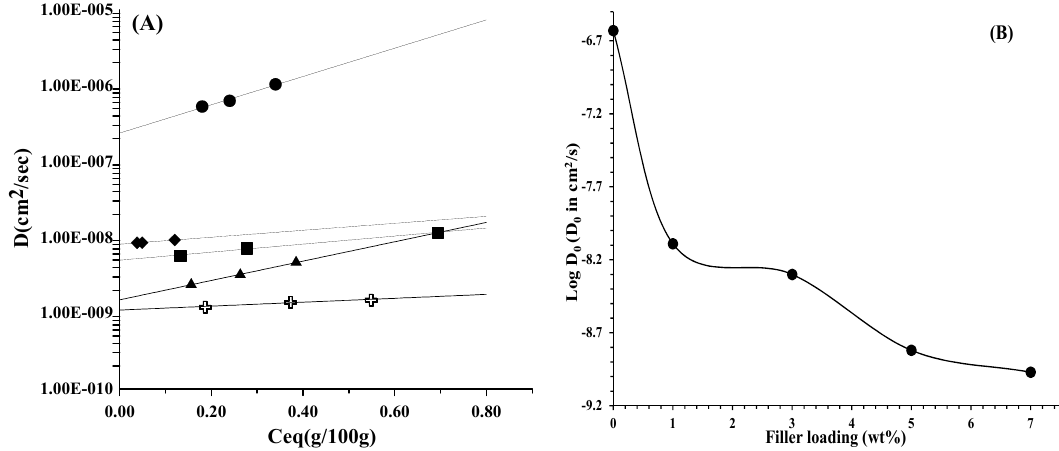
Figure 5. ( A ) The diffusion coefficient, D (cm 2 /s), as function of C eq (g/100 g) of water vapor for: PCL ( ); PCL/1% LDH-EHT ( ); PCL/3% LDH-EHT ( ); PCL/5% LDH-EHT ( ); and PCL/7% LDH-EHT ( ); and ( B ) the log D 0 as function of filler (LDH-EHT) loading (wt %).